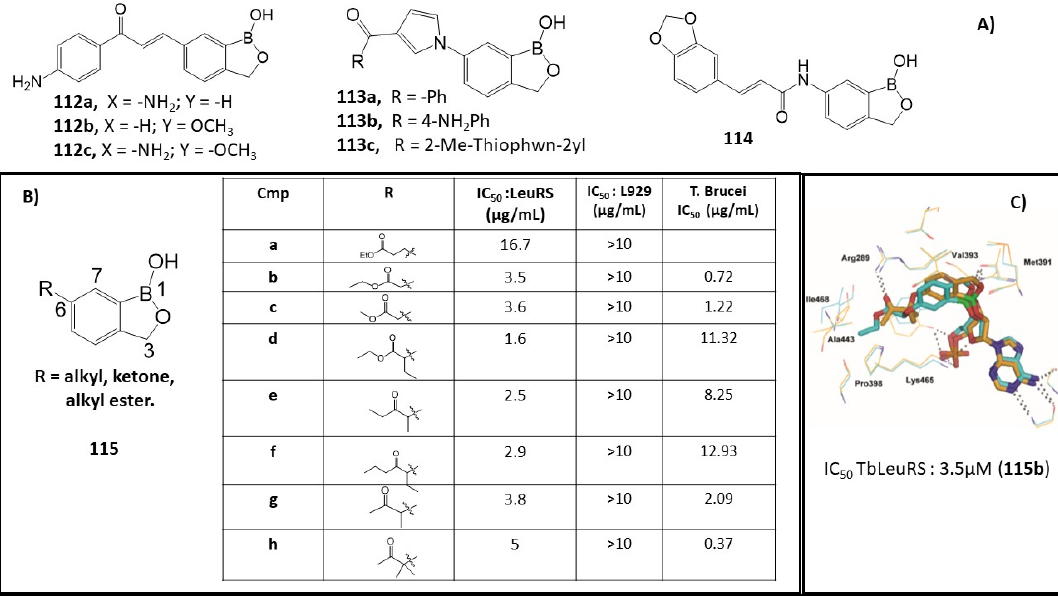
Figure 12. ( A ) Structures of chalcone–benzoxaborole 112 , pyrrolobenzoxaborole 113 and cinnamoyl–oxaborole 114 ; ( B ) Structures, antitrypanosomal activity and cytotoxicity of benzoxaboroles 115a – h ; ( C ) Binding of ester 115b (ligand in cyan sticks and binding site residues in cyan lines) in the editing pocket of Tbb LeuRS (Adapted from [87,104,105]).